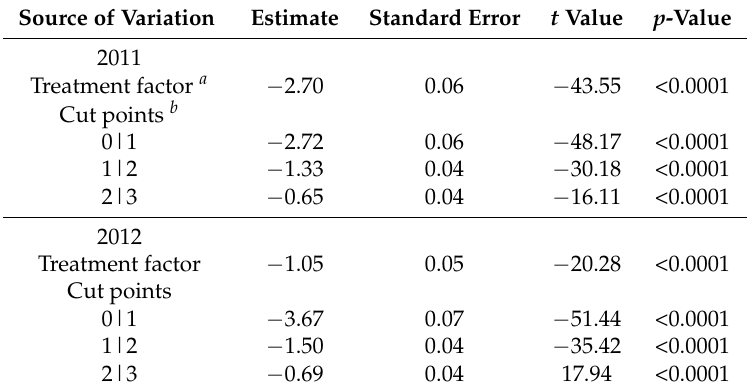
Table 3. Results obtained with the proportional odds logistic regression of greasy spot severity categories in experiment 2 on ‘Valencia’ sweet orange at Miraflores, Panama in 2011 and